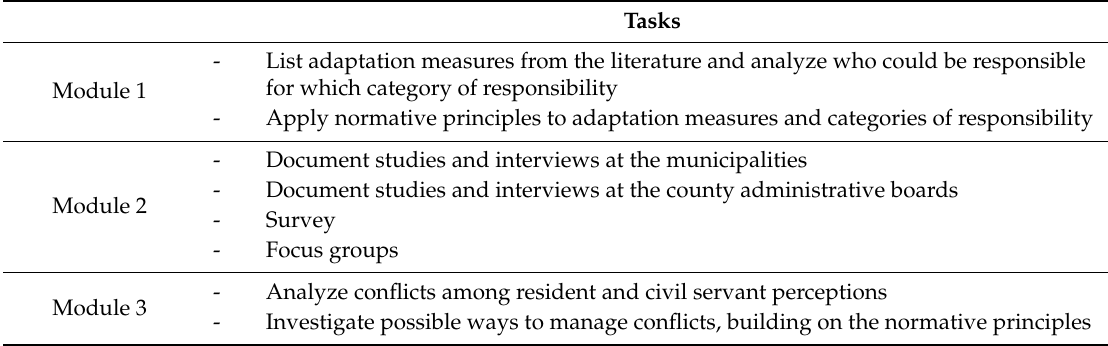
Table 1. Project